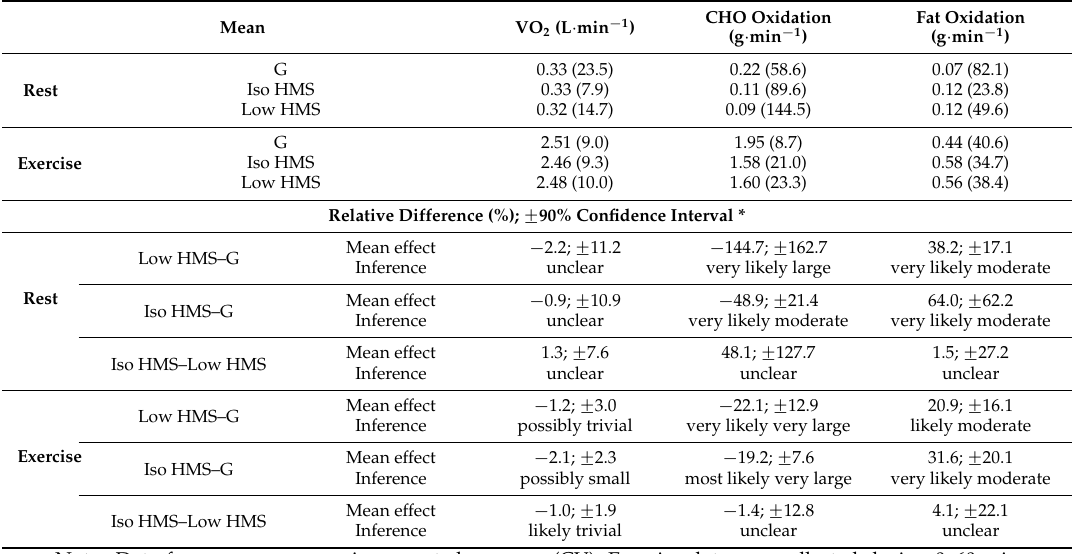
Table 1. Means and pairwise comparisons for oxygen consumption, total carbohydrate oxidation, and fat oxidation during steady state